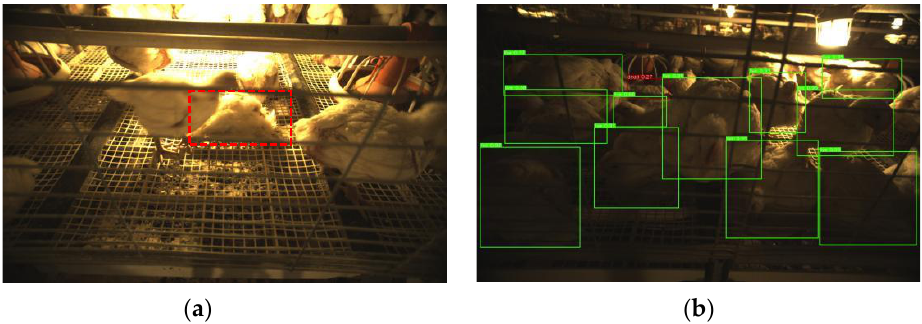
Figure 12. False detection sample of the improved-YOLOv3 model. ( a ) Difficult dead broiler sample. The dead broiler was marked with a red rectangular box. ( b ) False detection image.